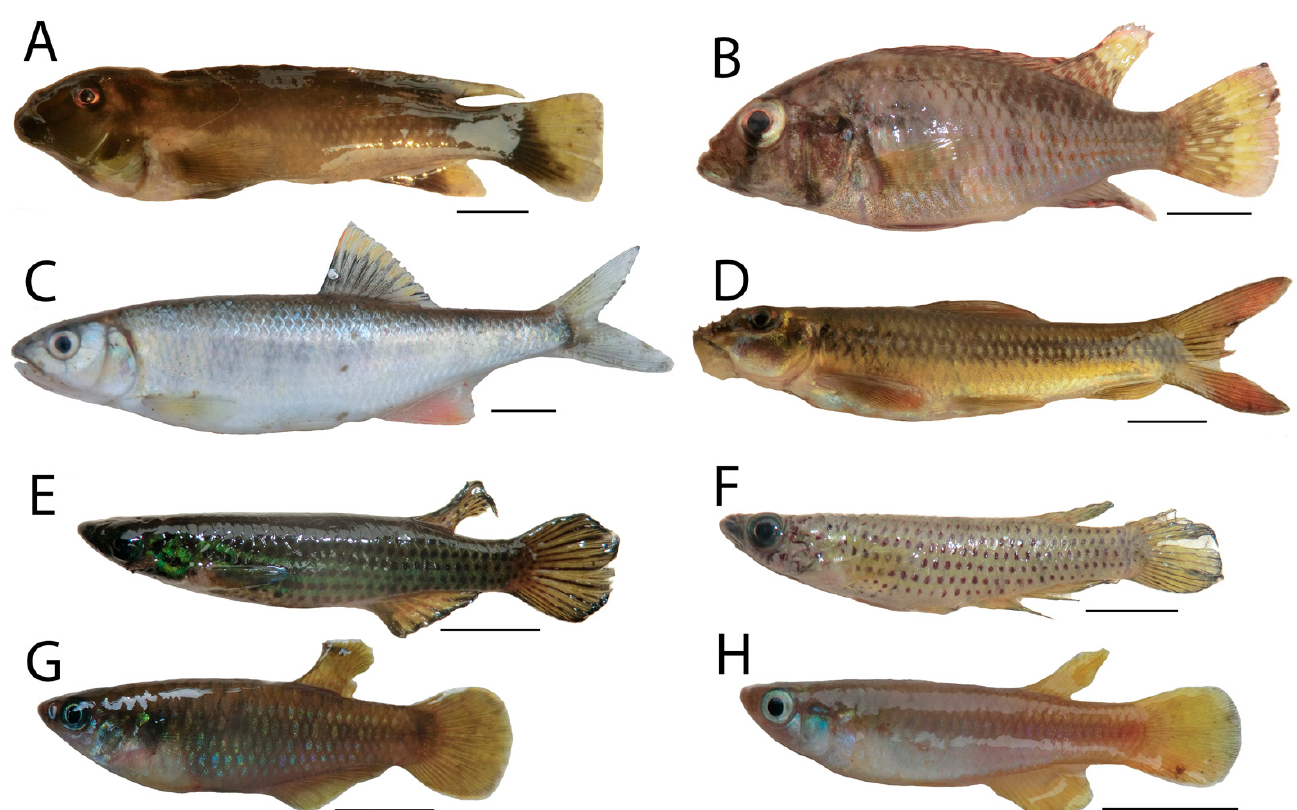
Figure A6. Selected endemic species of the LR: ( A ) Steatocranus rouxi ( B ) Ctenochromis luluae ( C ) Opsaridium boweni ( D ) Labeo luluae ( E ) Epiplatys atractus ( F ) Epiplatys sp “pale”. ( G ) Hypsopanchanx stiassnyae ( H ) Micropanchax sp. Photographed immediately postmortem, scale = 1 cm.